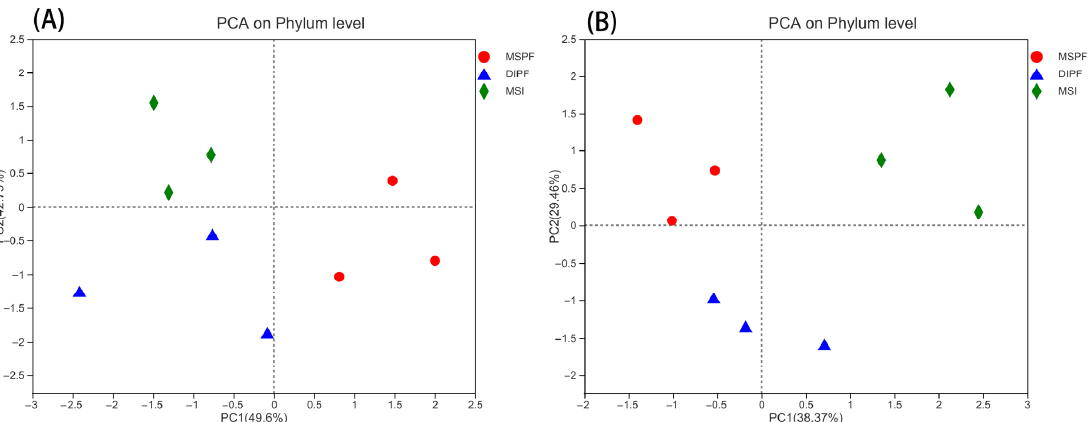
Figure 9. Principal component analysis (PCA) of denitrifying bacterial communities under different irrigation treatments during spring ( A ) and autumn ( B ). The points with the same color and shape indicate replicate samples for each treatment.